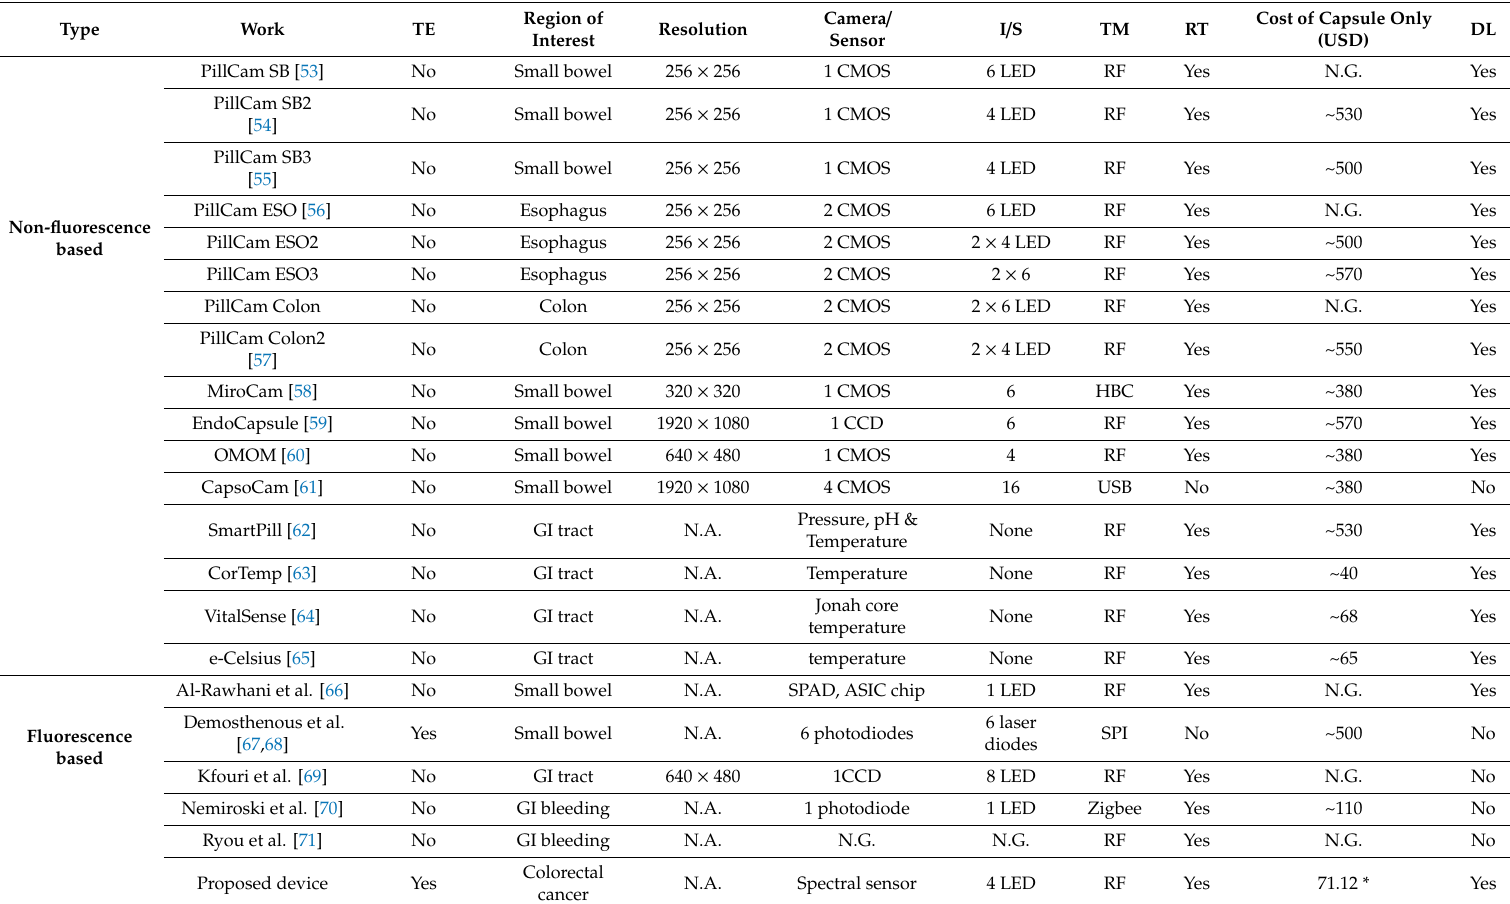
Table 4. Comparison with other devices: both commercial and research